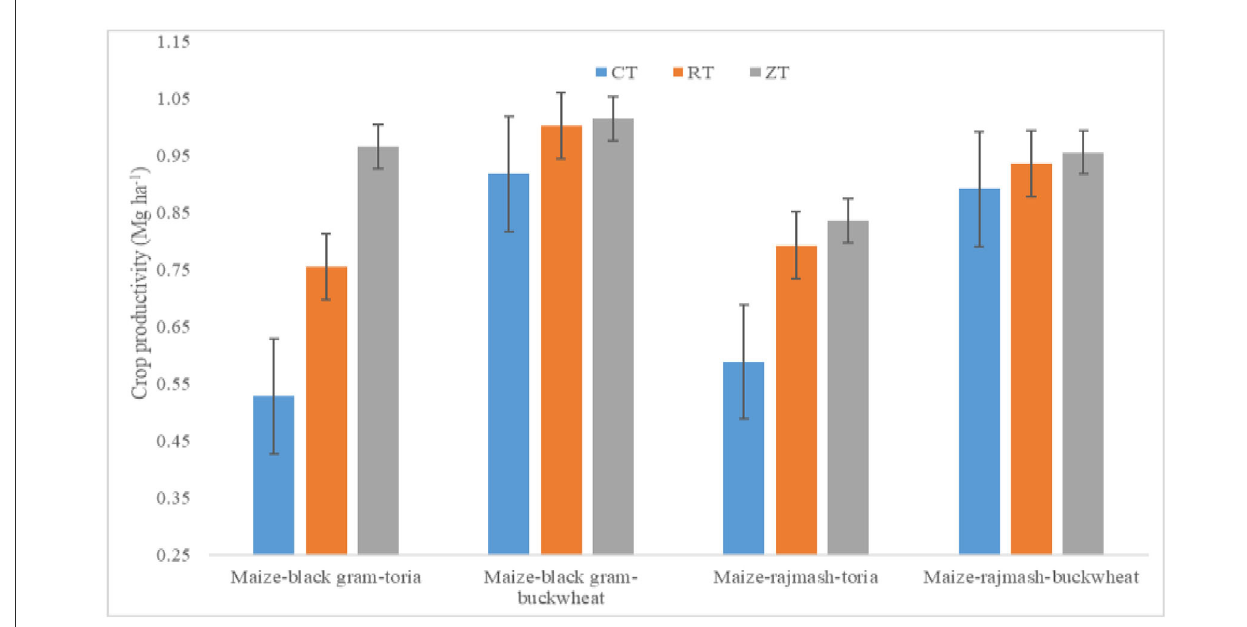
FIGURE3 Interactive effect of tillage and diversified cropping on the productivity of winter season crops. CT, conventional tillage; RT, reduced tillage; ZT, zero tillage. Error bar indicates the least significant difference (LSD) values at p = 0.05.